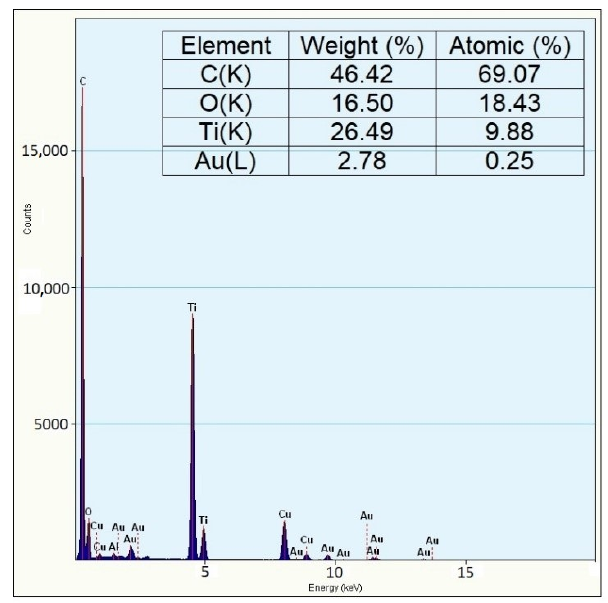
Figure 6. Energy dispersive X-ray (EDX) image for the as-synthesized TiO 2 /Au NSs.